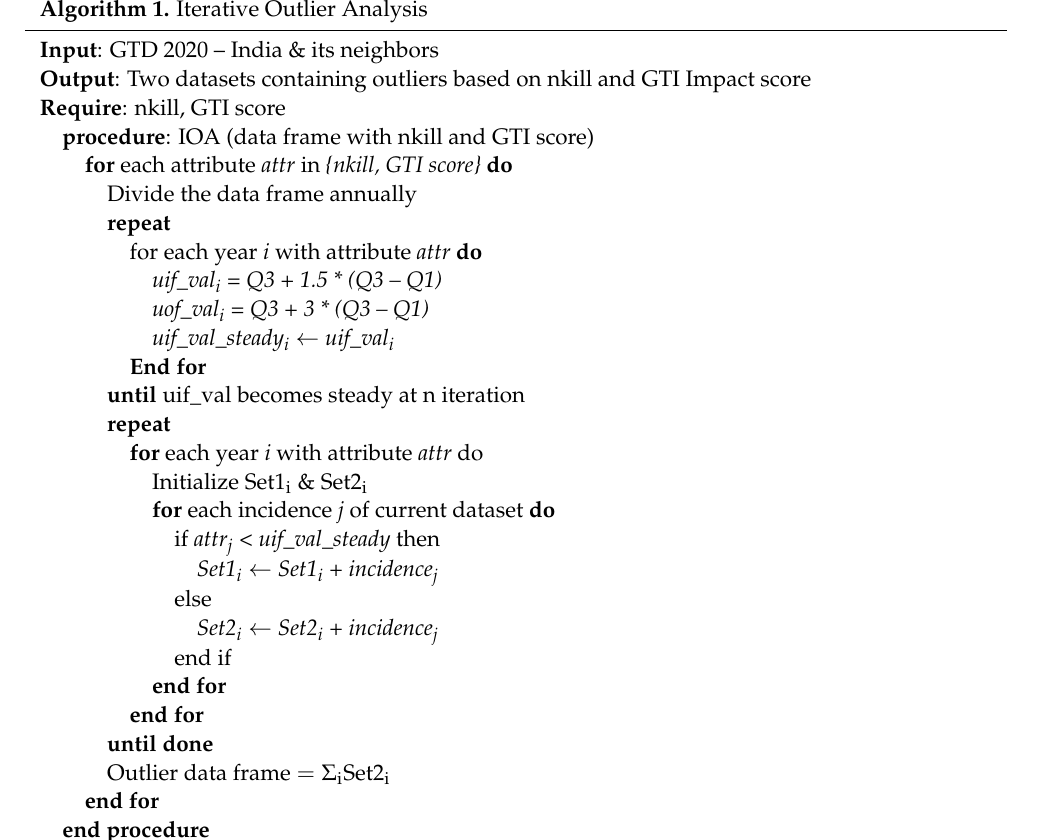
Algorithm 1. Iterative Outlier